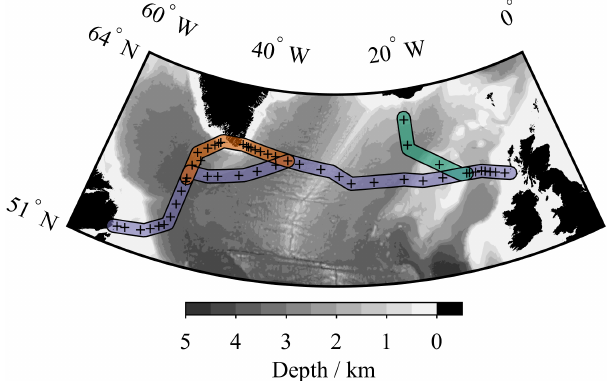
Figure 1. Bathymetric map of the subpolar North Atlantic Ocean. Black plusses show δ 13 C DIC sampling locations during cruise JR302. Coloured sections indicate illustrated transects: blue for Fig. 6, orange for Fig. 7, and green for Fig. 8. Bathymetry data are from the GEBCO_2014 grid, version 20150318, http://www.gebco.